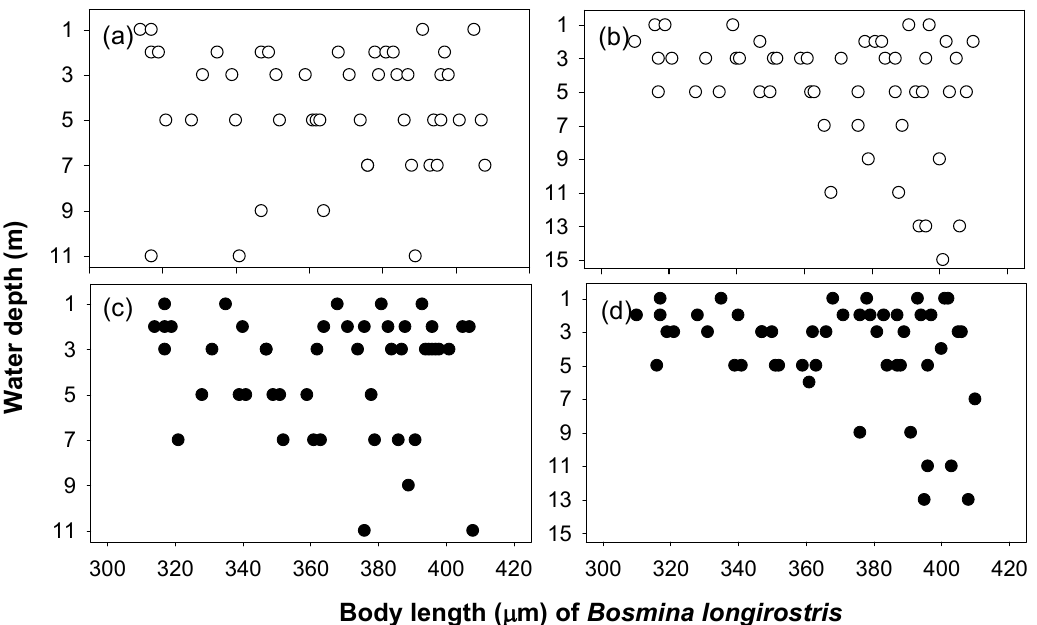
Figure 5. The relationship between body length ( µ m) of Bosmina longirostris and water depth during the daytime at sites 1 ( a ) and 3 ( b ) and during the night at sites 1 ( c ) and 3 ( d ).